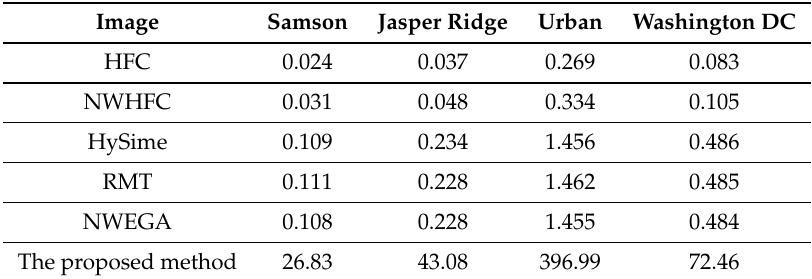
Table 4. Running times (in seconds) of each algorithm for each test image.